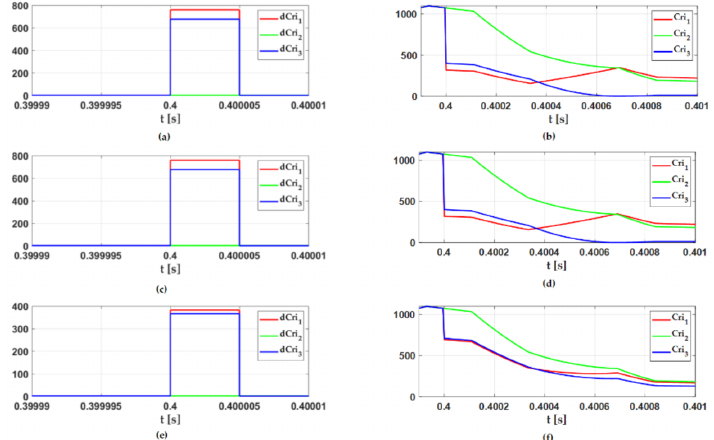
Figure 10. Marker transients in phase B under lack of signal ( b ), intermittent signal ( d ), variable gain ( f ) and their errors, respectively ( a , c , e ) in scalar